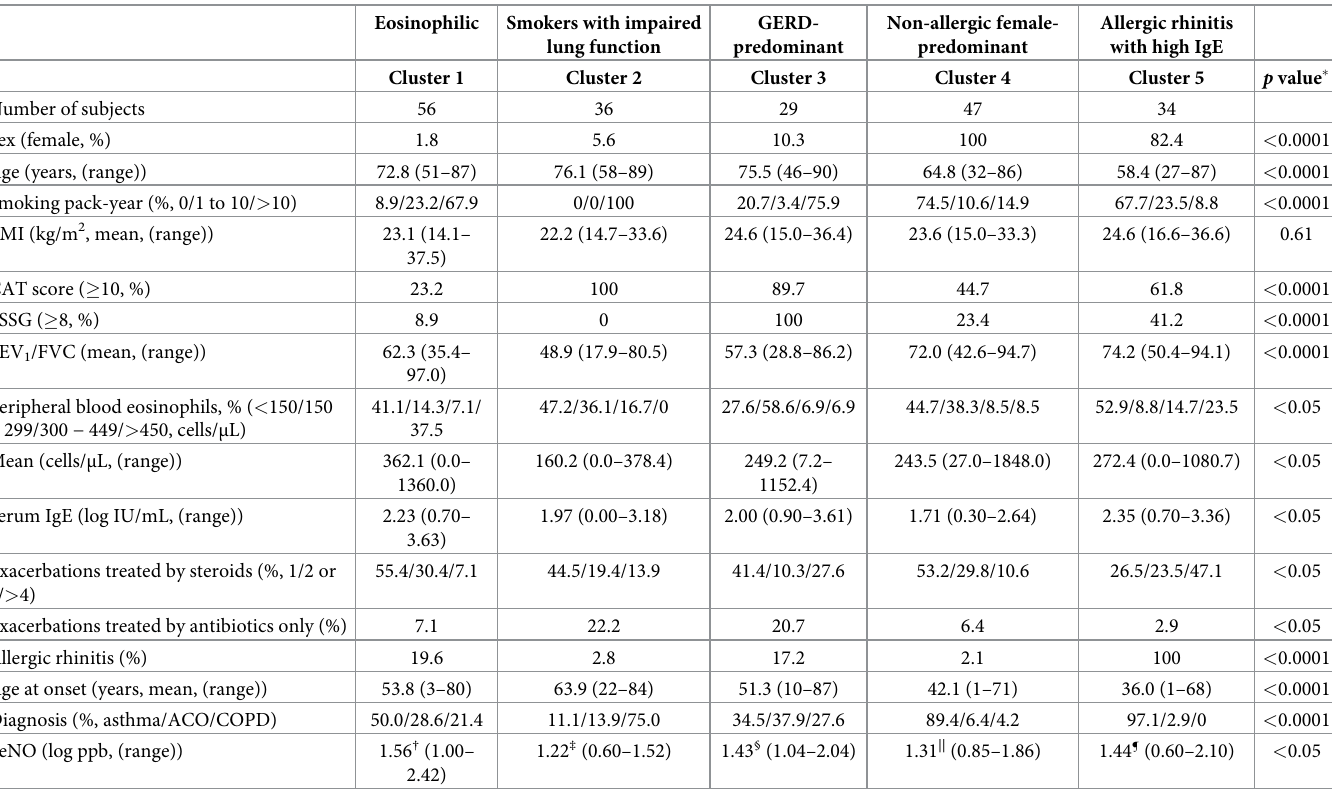
Table 2. Characteristics of the five